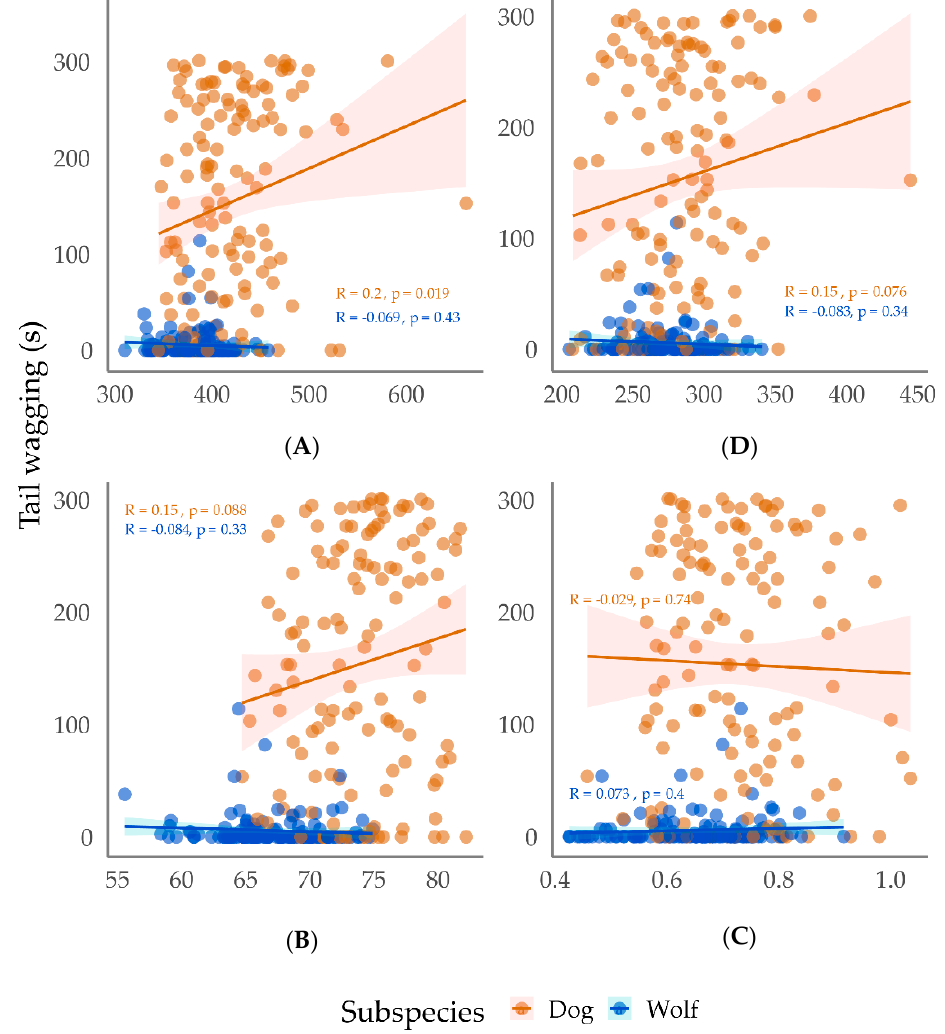
Figure 4. Dispersion of the time dogs ( Canis familiaris ) and wolves ( Canis lupus ) spent tail wagging in Positive Reinforcement Training sessions, as a function of acoustic characteristics of the trainers’ voices. Y axis = tail wagging duration of dogs and wolves (s); X axis = ( A ) maximum frequency (Hz), ( B ) average power (dB), ( C ) delta time (s), and ( D ) peak frequency (Hz). Each dot represents an individual training session.